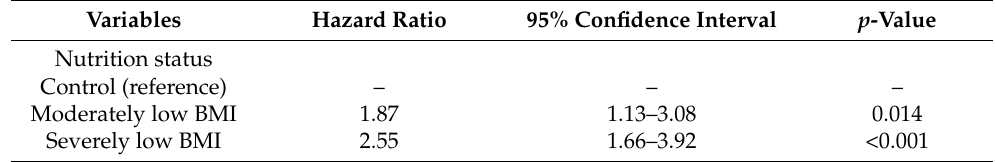
Table 3. Cox proportional hazards analyses for 30-day in-hospital